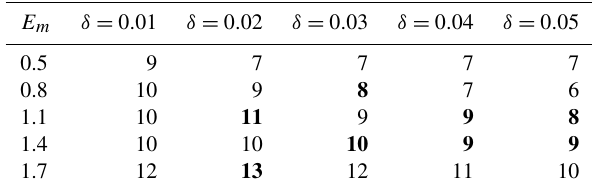
Table 7. The LBMPT computed by the filtering method.